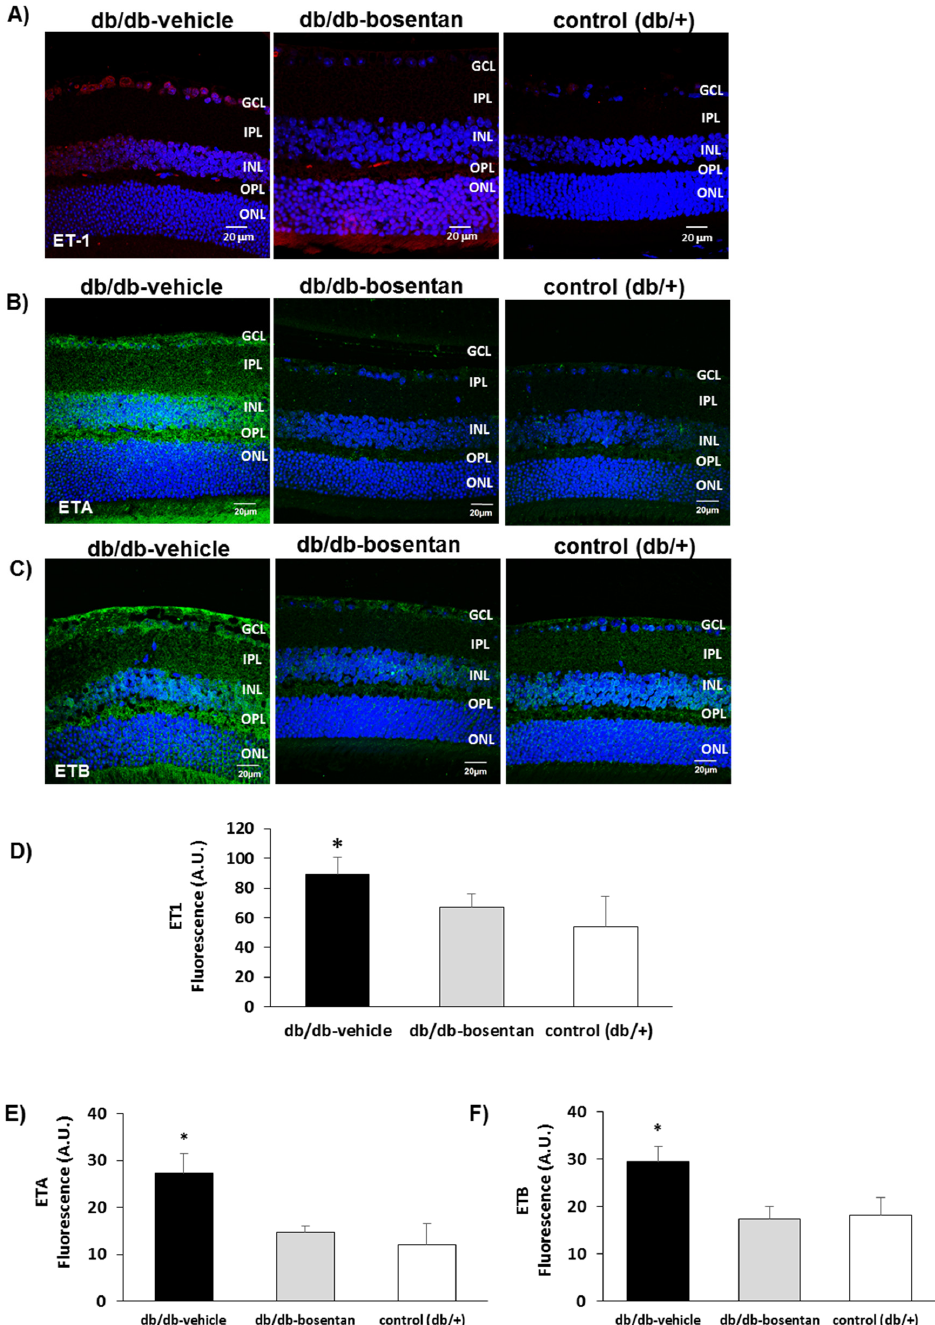
Figure 2. ( A ) Comparison of endothelin-1 immunofluorescence (red) between representative samples from a diabetic mouse (db/db) mouse treated with vehicle, a diabetic mouse treated with bosentan, and a non-diabetic mouse (db/+); ( B ) Comparison of endothelin receptor A immunofluorescence (green) between representative samples from a diabetic mouse (db/db) mouse treated with vehicle, a diabetic mouse treated with bosentan, and a non-diabetic mouse (db/+); ( C ) Comparison of endothelin receptor B immunofluorescence (green) between representative samples from a diabetic mouse (db/db) treated with vehicle, a diabetic mouse treated with bosentan, and a non-diabetic mouse (db/+). GCL: Ganglion cell layer; IPL: Inner plexiform layer; INL: Inner cell layer; OPL: Outer plexiform layer; ONL: Outer nuclear layer. Scale bar: 20 µ m; ( D – F ) Quantification of immunofluorescence. AU: Arbitrary units. Data are expressed as mean ± SD. * p < 0.05 in comparison with the other